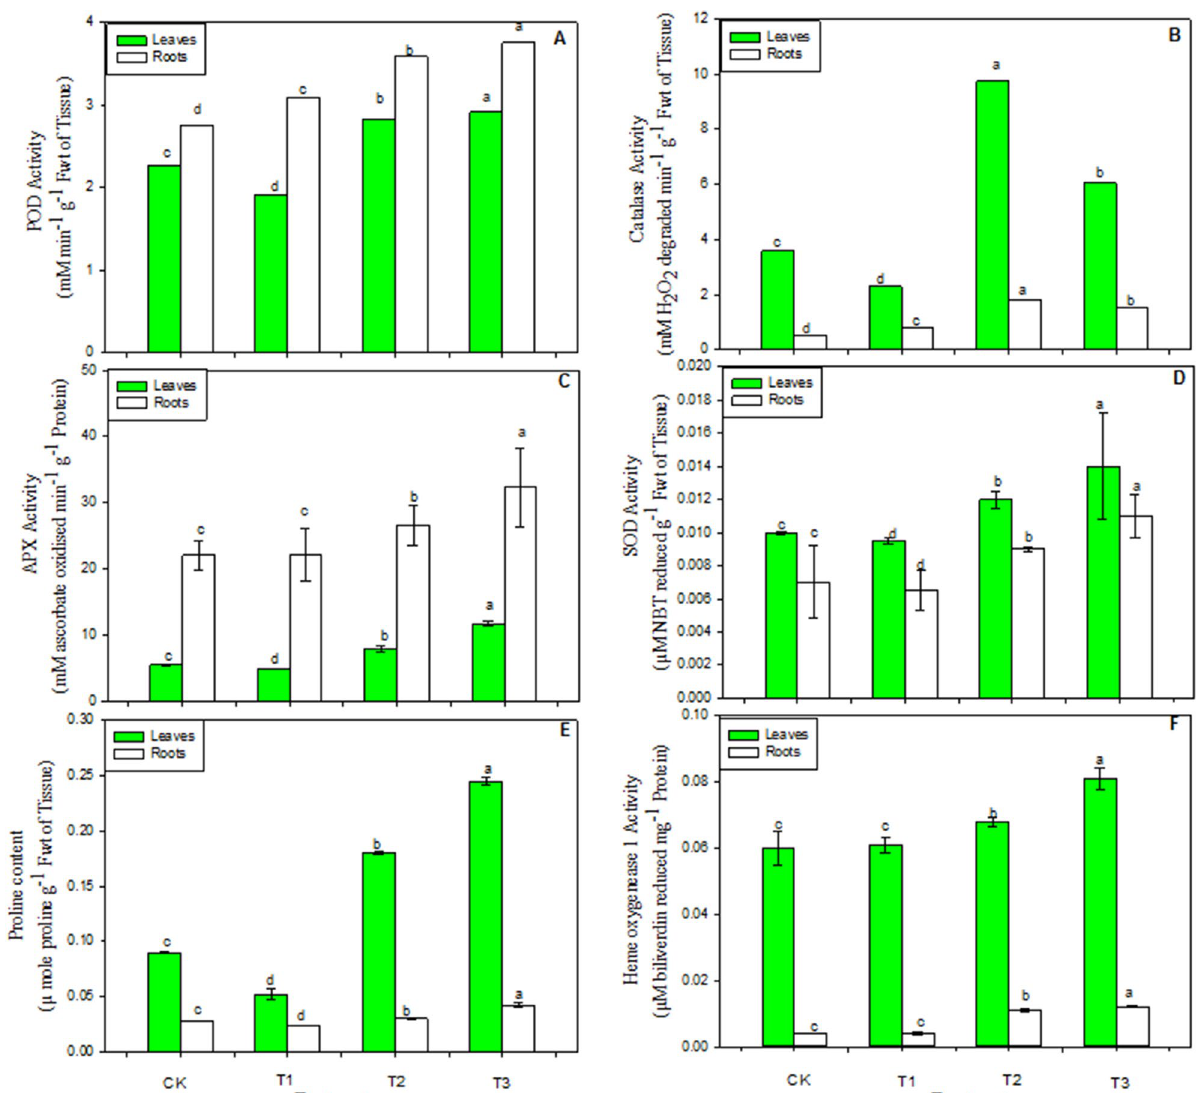
Figure 3. ( A ) Peroxidase (POD) ( B ) Catalase (CAT) ( C ) Ascorbate peroxidase (APX) ( D ) Superoxide dismutase (SOD) ( E ) Proline conent and F Haem oxygenase-1 activity in seedlings of Vigna radiata. Seedlings were treated with 50 μM CdCl 2 independently and in combination with 0.5 mM hemin for 4 days. Values are mean ± SE of three replicates (n = 3) and are statistically significant according to DMRT test (p < 0.05). Data points marked with the same letters show insignificant differences (p < 0.05) within